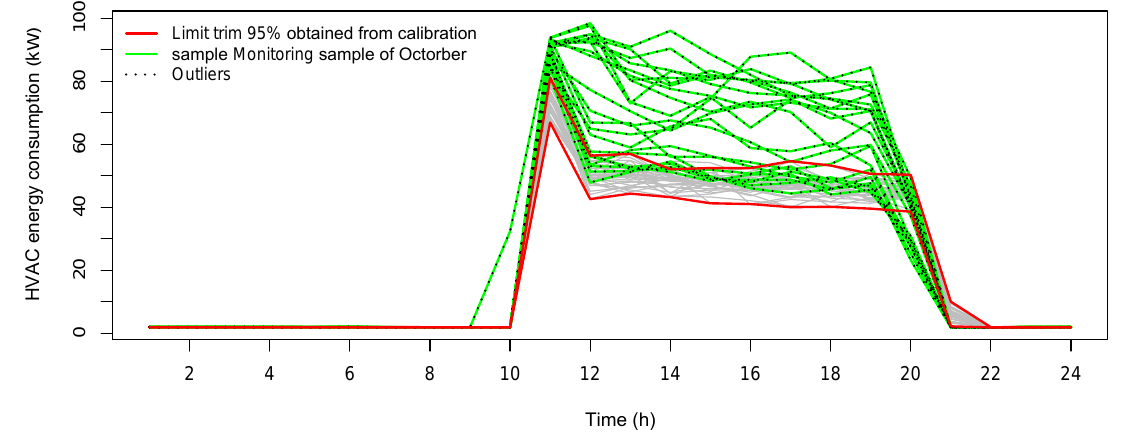
Figure 6. Reference of calibration and monitored samples corresponding to October.